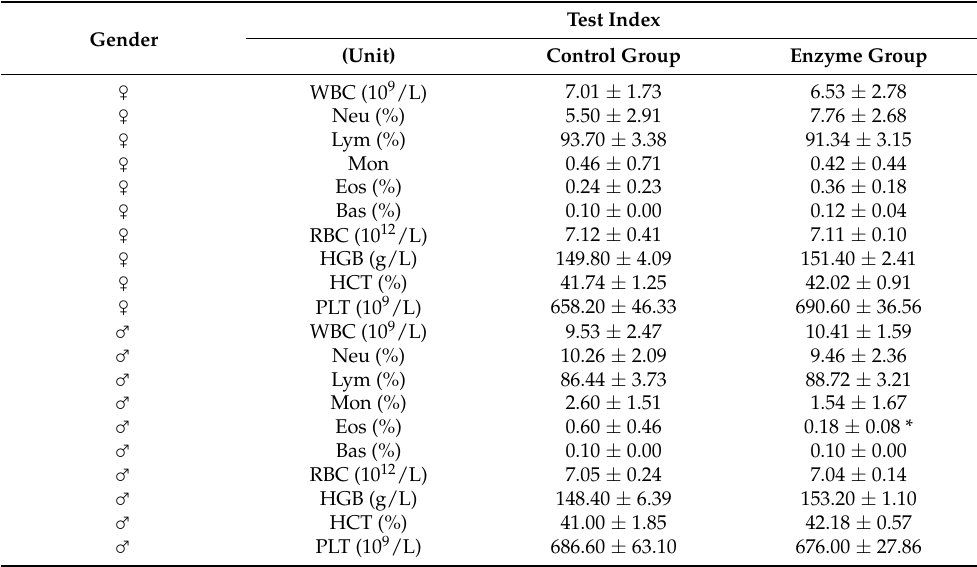
Table 3. Effects of enzyme solution on hematology of rats ( n = 5).